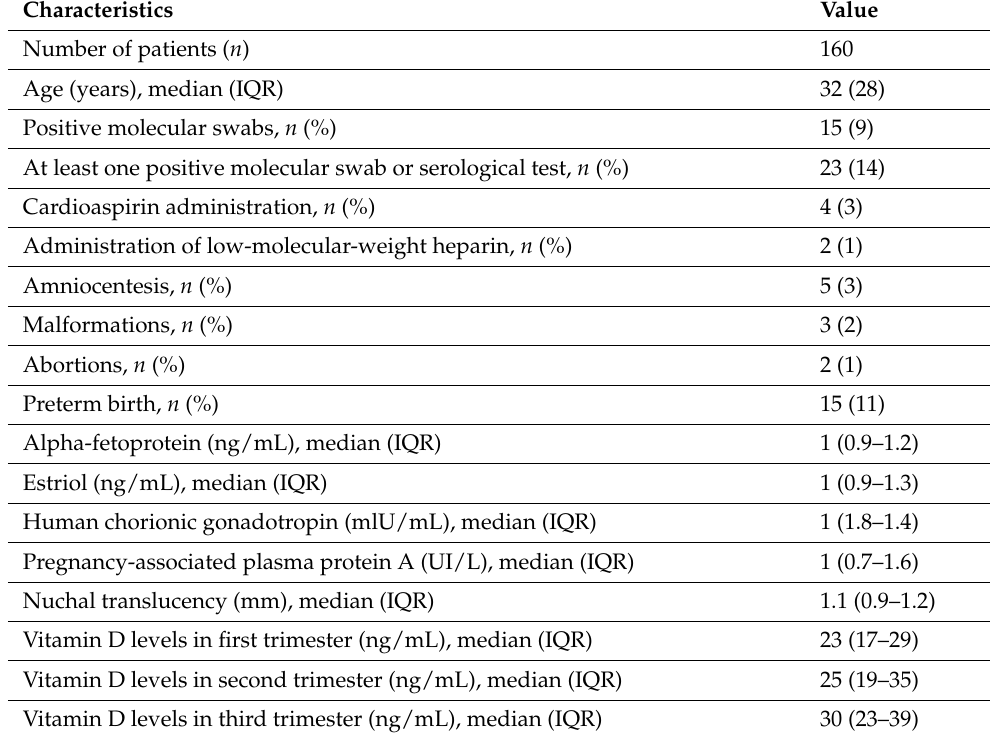
Table 1. Patients’ characteristics (IQR = interquartile